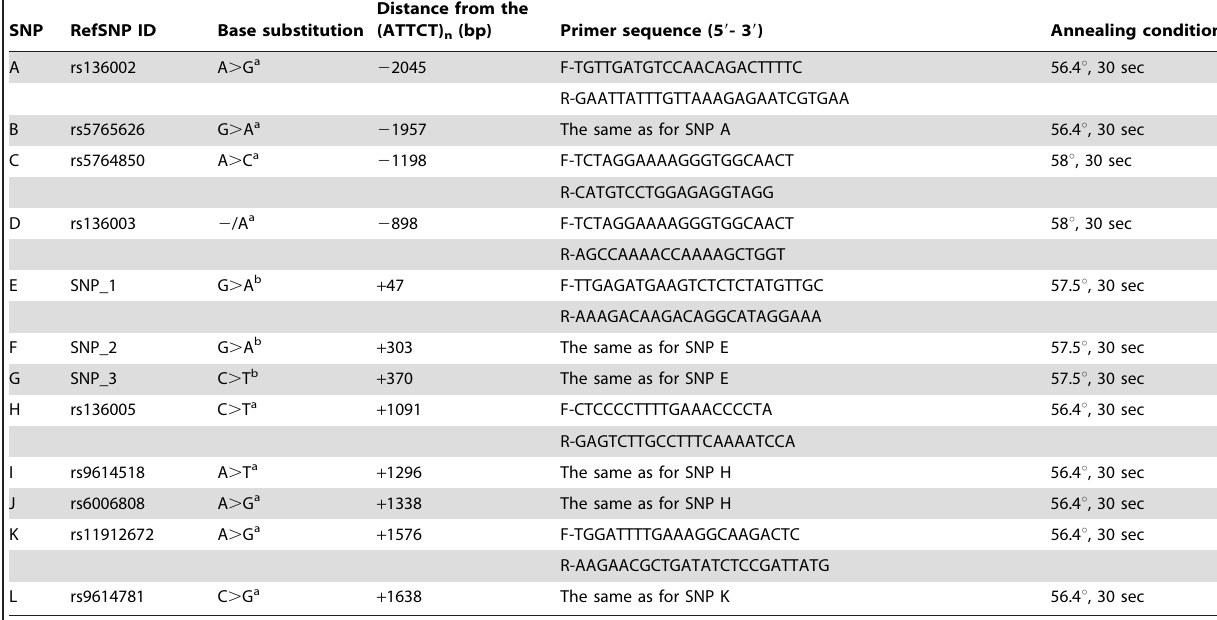
Distance from the (ATTCT) n